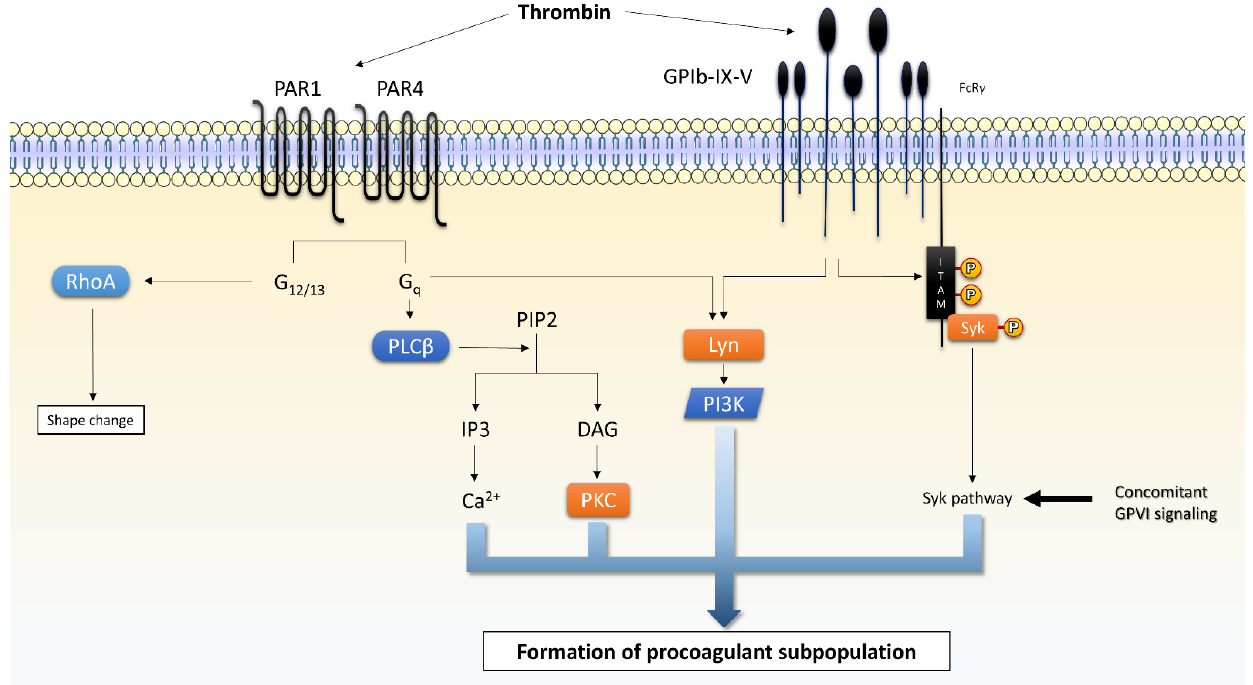
Figure 4. Thrombin-mediated signaling. Thrombin activates platelets through two types of receptors acting in a synergistic way: the G protein-coupled receptors PAR 1/4 and the GPIb α from the GPIb-IX-V complex. This figure is inspired, simplified, and adapted from [24,140,150]. Legend: Ca 2+ : calcium, DAG: Diacylglycerol; G: guanine nucleotide-binding proteins; IP3: inositol trisphosphate; ITAM: immuno-receptor tyrosine activation motif; PAR: protease-activated receptors; PKC: protein kinase C; PI3K: phosphatidylinositide-3-kinase; PIP2: phosphatidylinositol-4,5-bisphosphate; PLC: phospholipase C; Rap1: Ras-related protein 1; RhoA: Ras homolog family member A; Syk: spleen tyrosine kinase.